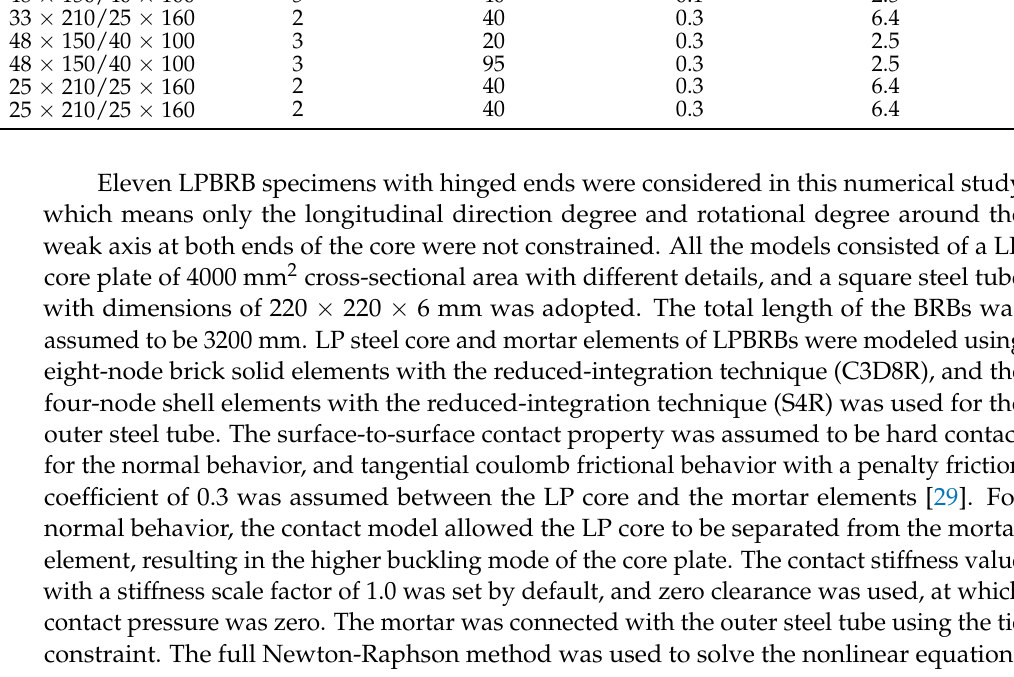
Figure 4. Local bulging of the outer tube.